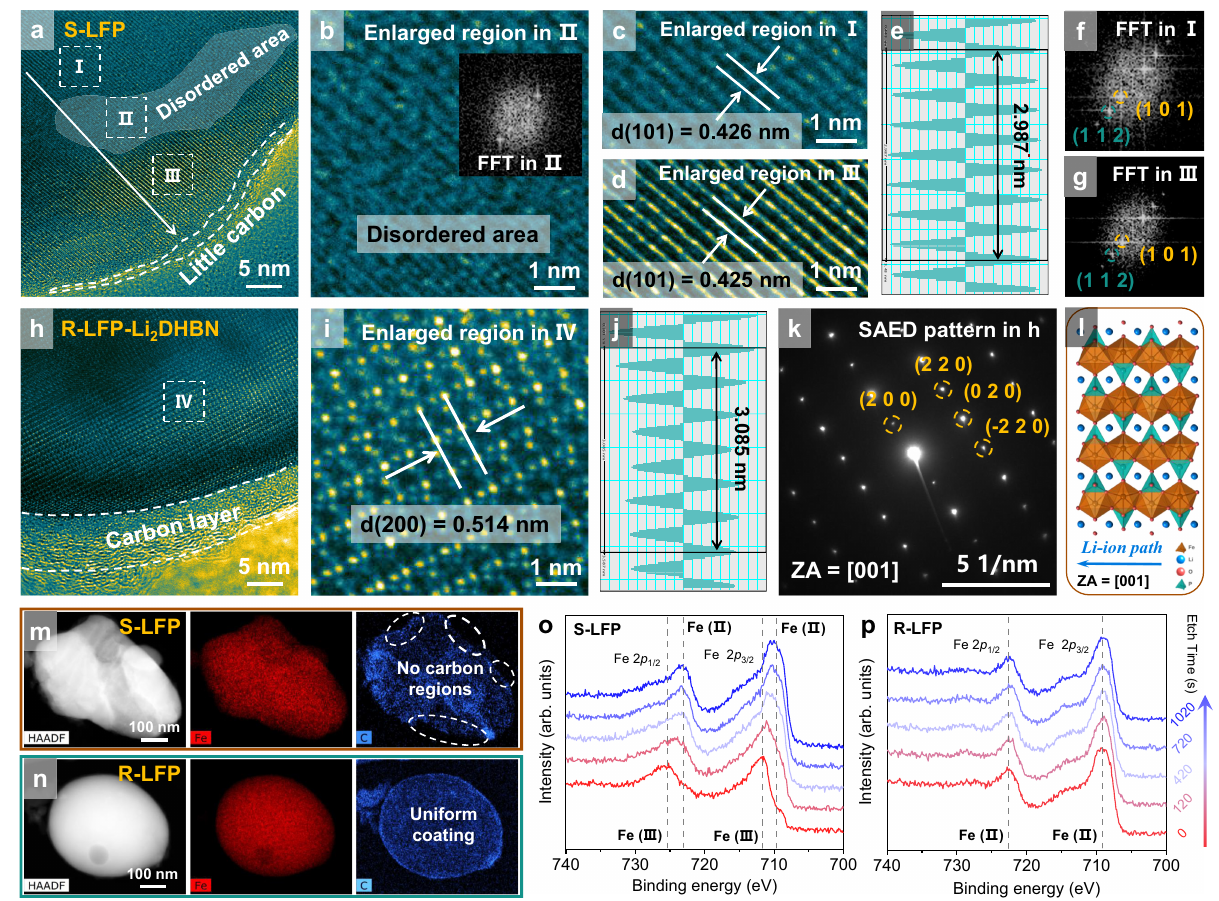
Fig. 2 | Microstructure characterization of the degraded and restored LFP cathodes. a HRTEM image, b – d enlarged fi gures, e line pro fi les in d and f , g fast Fouriertransform(FFT)imagesofS-LFP. h HRTEM, i enlarged fi gure, j linepro fi les